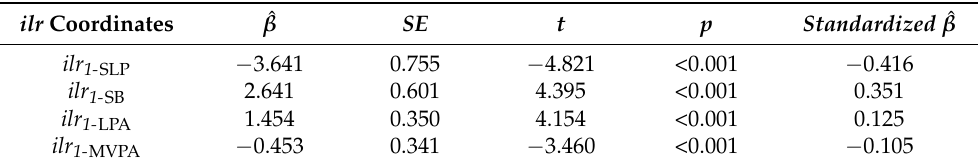
Table 4. Correlation between 24-Hour movement behavior and smartphone addiction score during the epidemic.